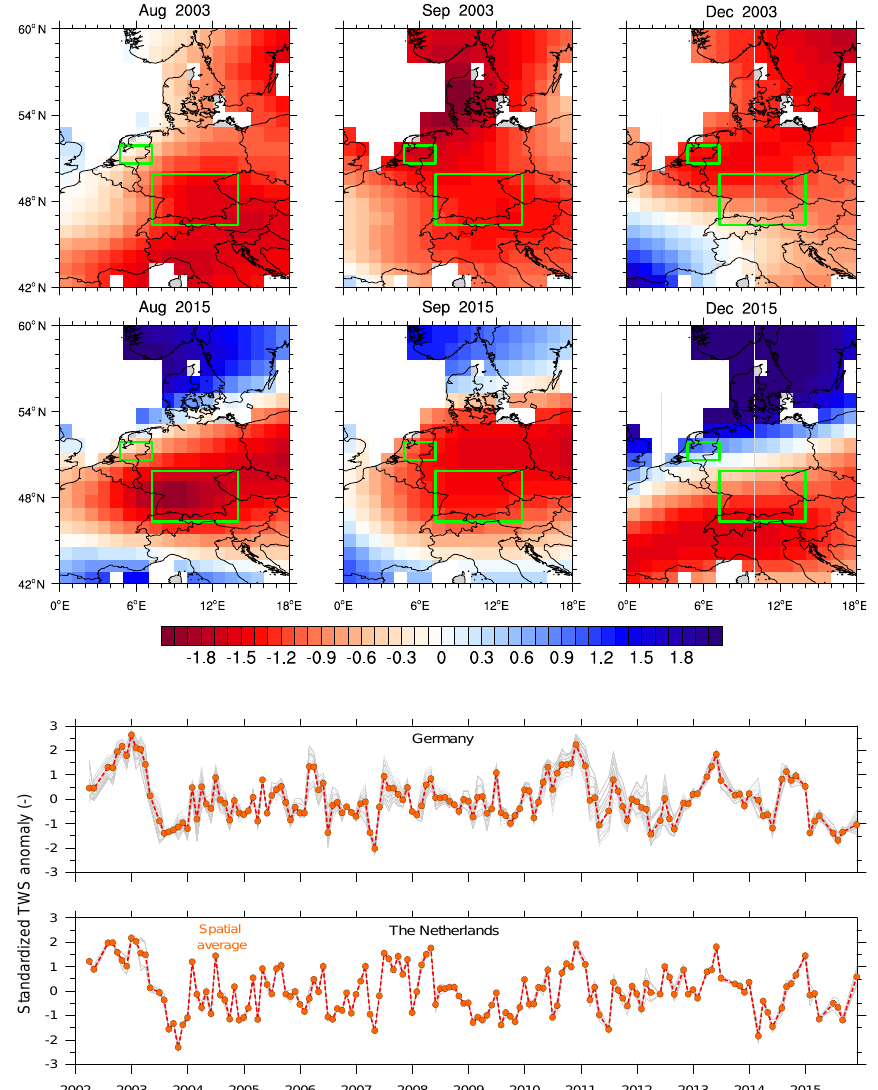
Figure 4. Same as Fig. 3 but after standardisation of the TWS anomalies to de-emphasise the seasonality component of TWS anomalies.